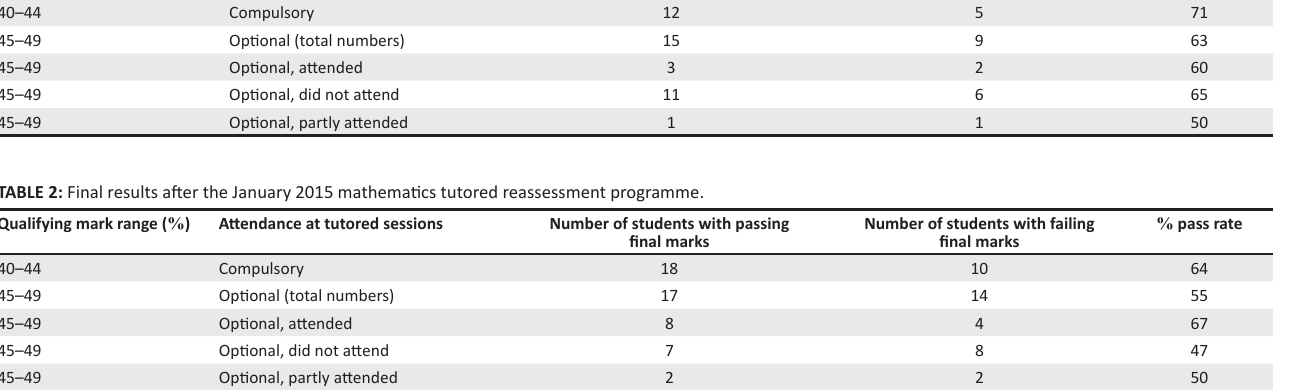
TABLE 1: Final results after the July 2014 mathematics tutored reassessment programme. Qualifying mark range ( % )